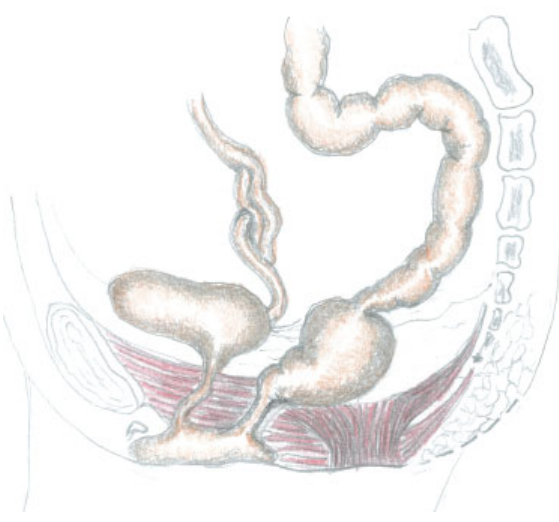
Fig. 2 Anatomy of the patient.